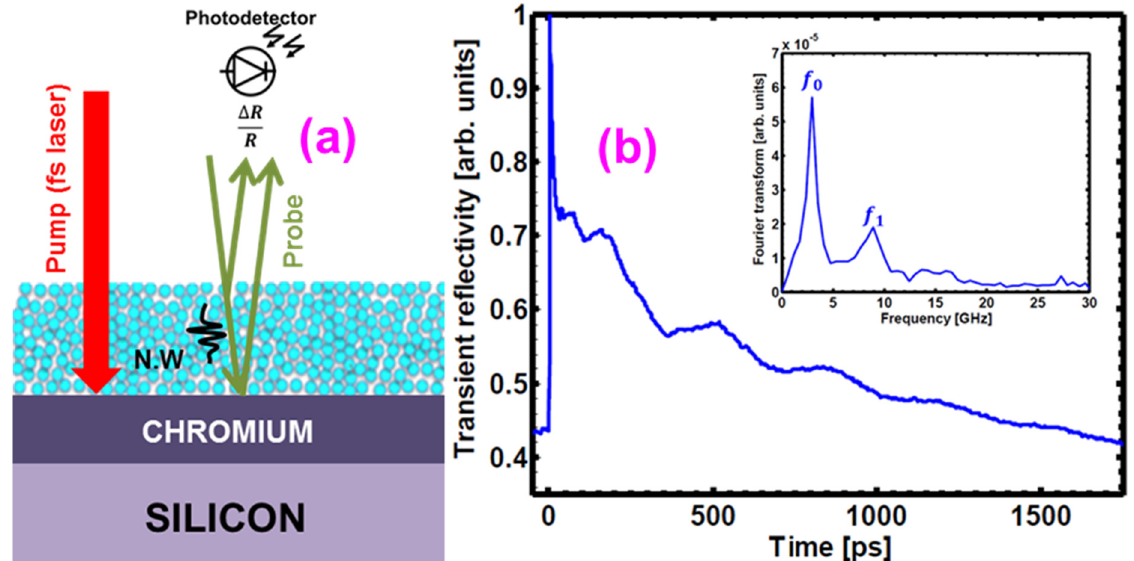
Figure 18. ( a ) Scheme of laser ultrasonic measurements carried out, where NW stands for nanoacoustic waves. An fs pump laser beam excited the sample leading to the generation of an acoustic wave in the chromium transducer. The acoustic wave propagated into the film under study and induced a local refractive index change in the material. The fs probe laser beam met this refractive index modification, and its reflection R of the sample was modified. This ∆ R/R signal was detected ( b ) Transient optical reflectivity ( ∆ R/R) signal revealing the oscillating component due to the mechanical resonances of the coating.